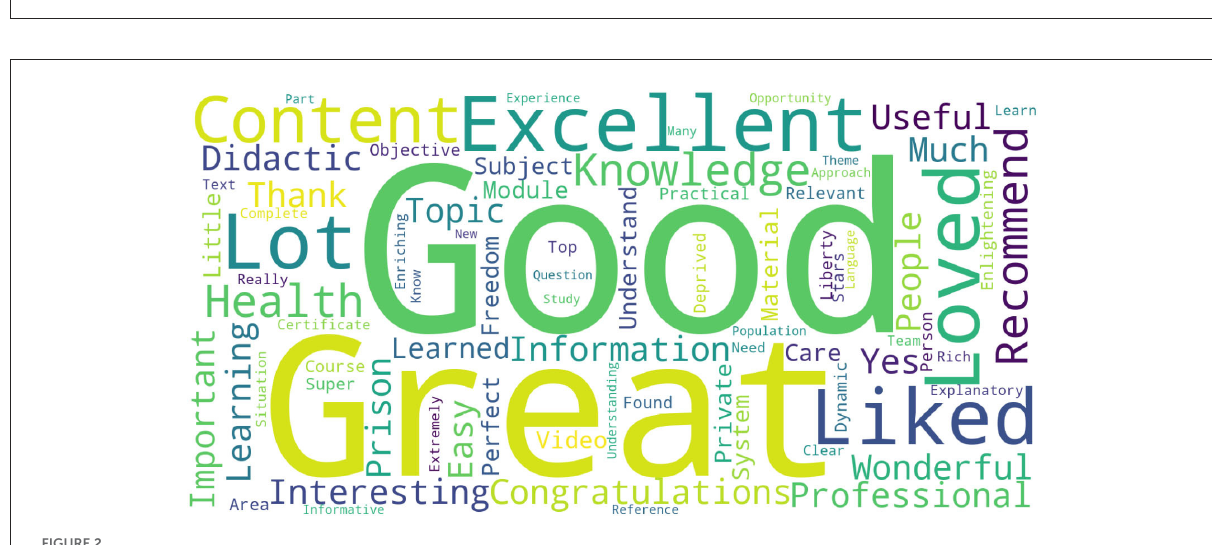
FIGURE2 Word cloud of participants’